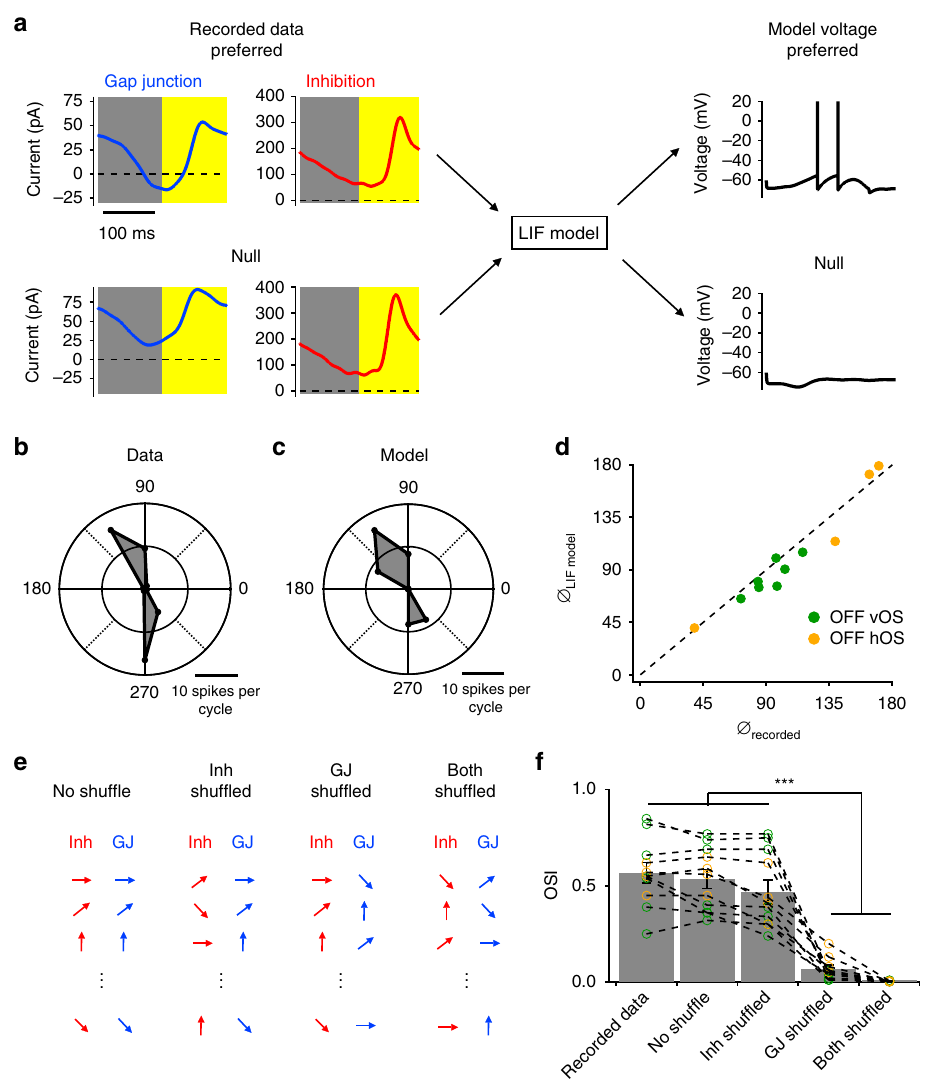
Fig. 8 Leaky integrate and fi re model of OFF OS RGCs. a Flowchart of the LIF model. Recorded cycle average gap junction and inhibitory currents measured in response to drifting grating stimuli were used as inputs in the LIF model to generate resulting membrane potential for different grating movement directions. b Polar plot of cell attached drifting grating responses of an example OFF OS RGC. c Simulated drifting grating response generated by the LIF model using the currents measured from the cell in b . d Scatter plot of recorded OS angles ( θ recorded ) vs. LIF model OS angles ( θ LIF model ). e Schematic showing the logic of different shuf fl ing conditions of input currents. f OSI of the recorded data from four horizontal OFF OS RGCs (orange points) and seven vertical OFF OS RGCs (green points) along with OSI values from four different LIF model shuf fl ing conditions. Dashed lines connect data and models from the same cells. Error bars indicate SEM across n = 11 cells. *** p <